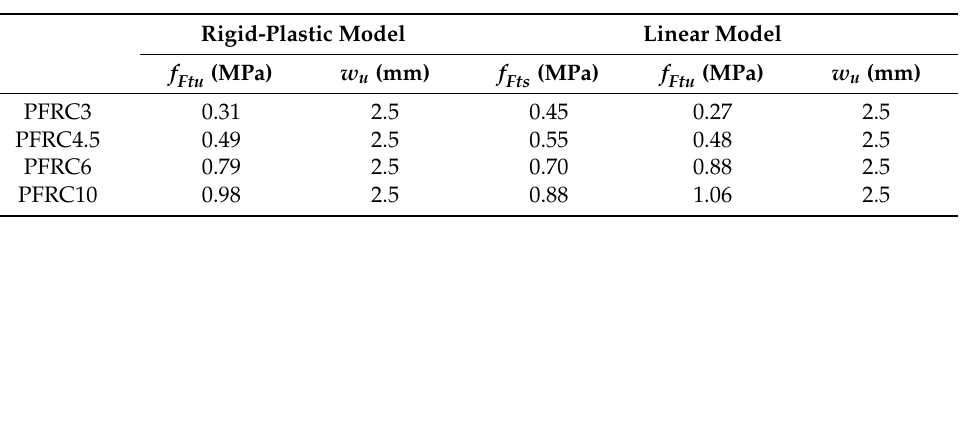
Table 1. Parameters of the rigid-plastic and the linear models for each fibre dosage of PFRC. Rigid-Plastic